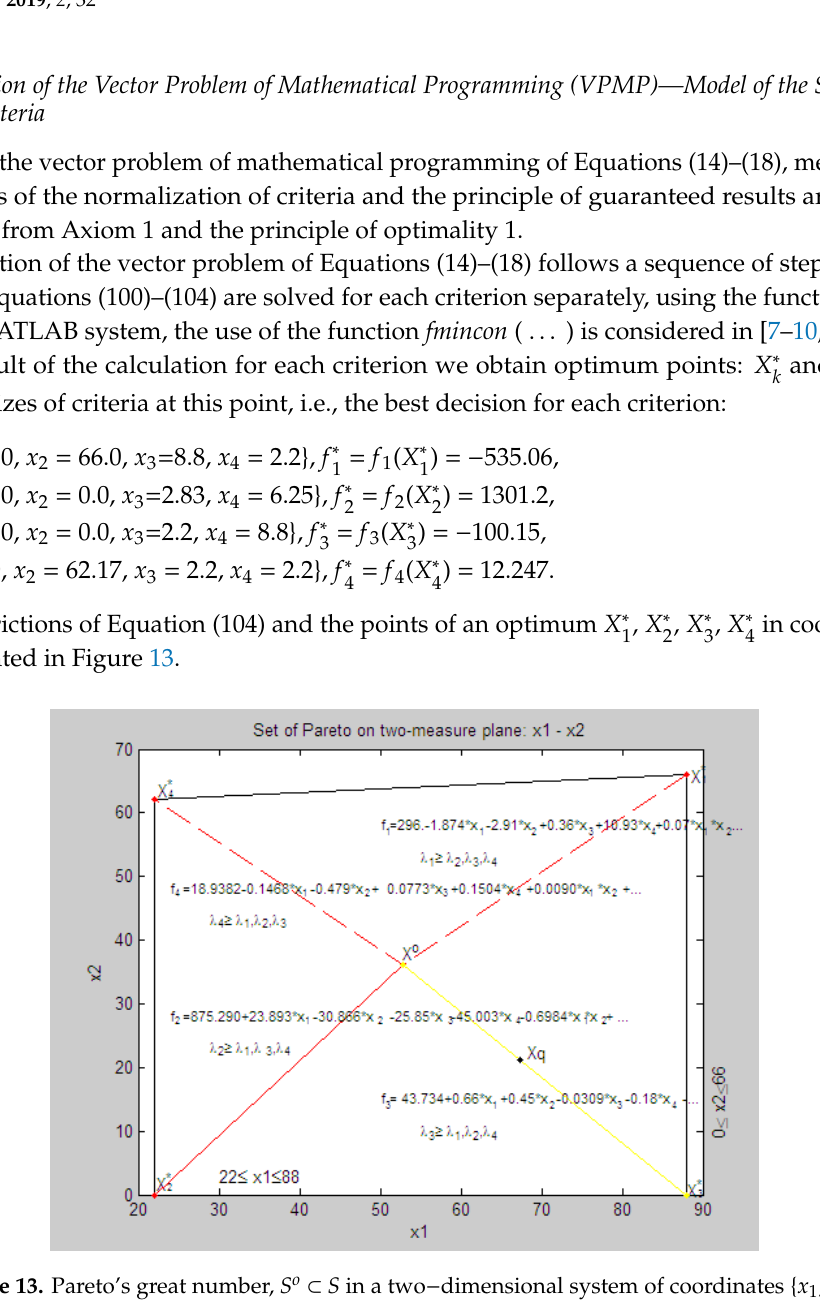
Figure 13. Pareto ’ s great number, S o  S in a two − dimensional system of coordinates { x 1 , x 2